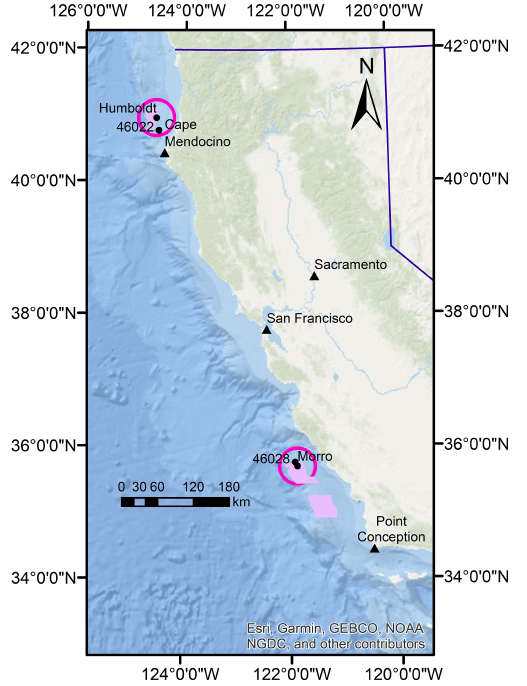
Figure 1. Locations of the DOE buoys and nearby National Data Buoy Center buoys 46022 and 46028. The purple-shaded regions around the buoys show Bureau of Ocean Energy Management wind energy areas as of 12 January 2022. GEBCO: General Bathymetric Chart of the Oceans. NGDC: National Geophysical Data